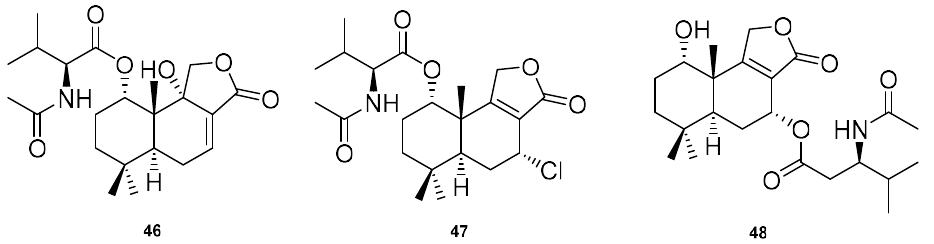
Figure 12. Cytotoxic drimane 45 from Fomes officinalis against HL-60, Bel-7402, and KB cells [59]. S. Ngokpol et al. isolated drimane sesquiterpene-conjugated amino acids 46 – 48 from Talaromyces minioluteus and evaluated their cytotoxicity against the human hepatocellular carcinoma cell line HepG2 (Figure 13) [60]. Compounds 47 and 48 are four-fold more active than 46 .